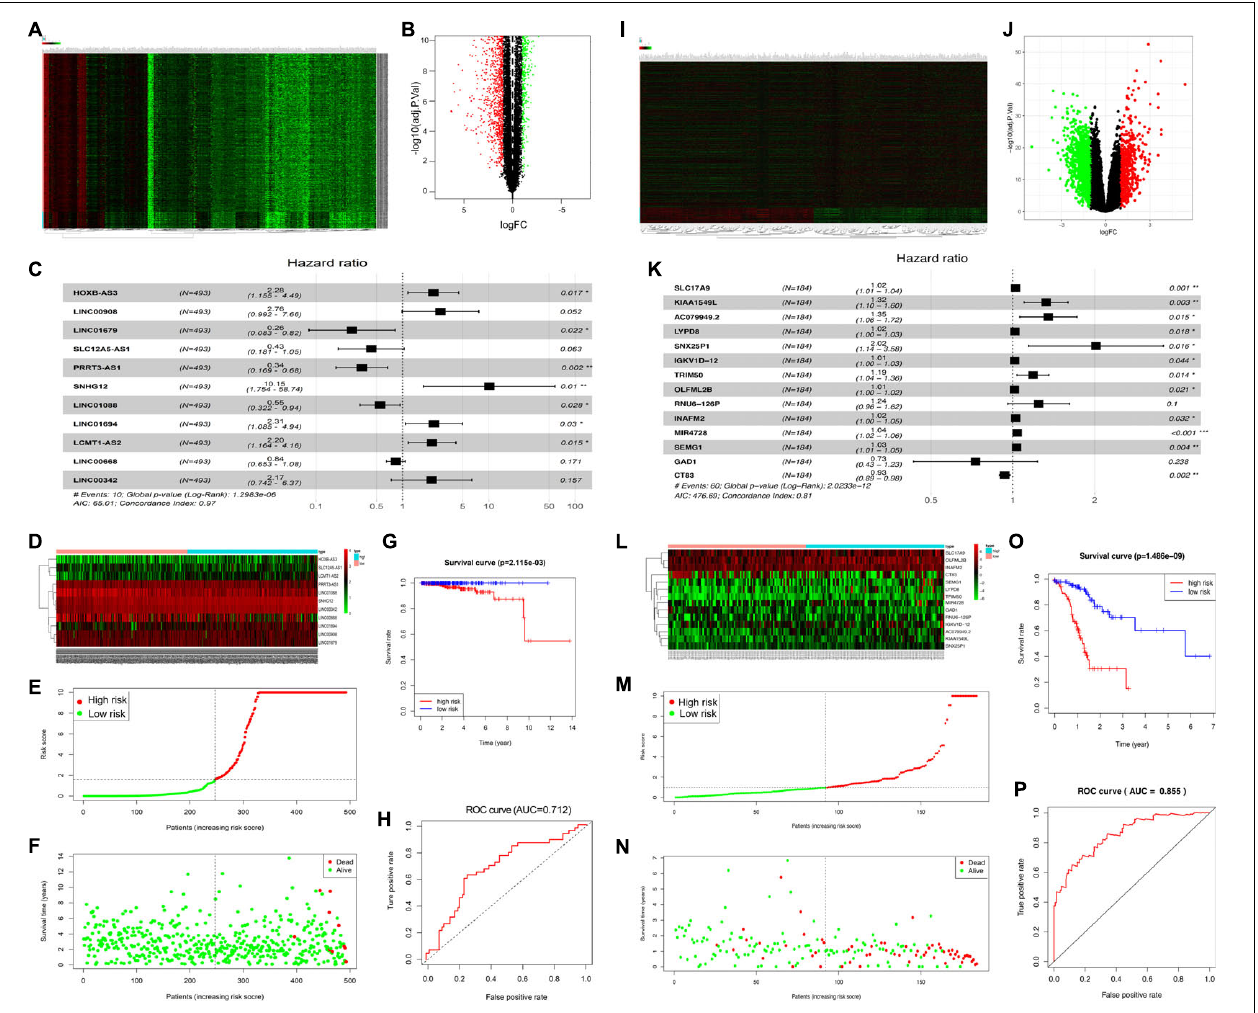
FIGURE 1 | Identification of significant PCa-related DElncRNAs and DEGs. Heat map demonstrating the DElncRNAs (A) and DEGs (I) . Volcano plot showing the DElncRNAs (B) and DEGs (J) , FC, fold change. (C) Forest map showing HRs (95% CIs) together with p -values for those screened DElncRNAs, and DEGs (K) by univariate Cox proportional hazards analysis. Heat map displaying the expression levels of OS-related DElncRNAs (D) and DEGs (L) in the high-risk and low-risk groups. (E,M) Risk curve plotted according to risk scores of all samples. (F,N) Scatterplot drawn according to patient survival status, where red and green dots denote death and survival, respectively. (G,O) KM curve showing the survival between low- and high-risk groups according to median risk score and risk model. (H,P) AUC values of clinical characteristics and risk score based on ROC